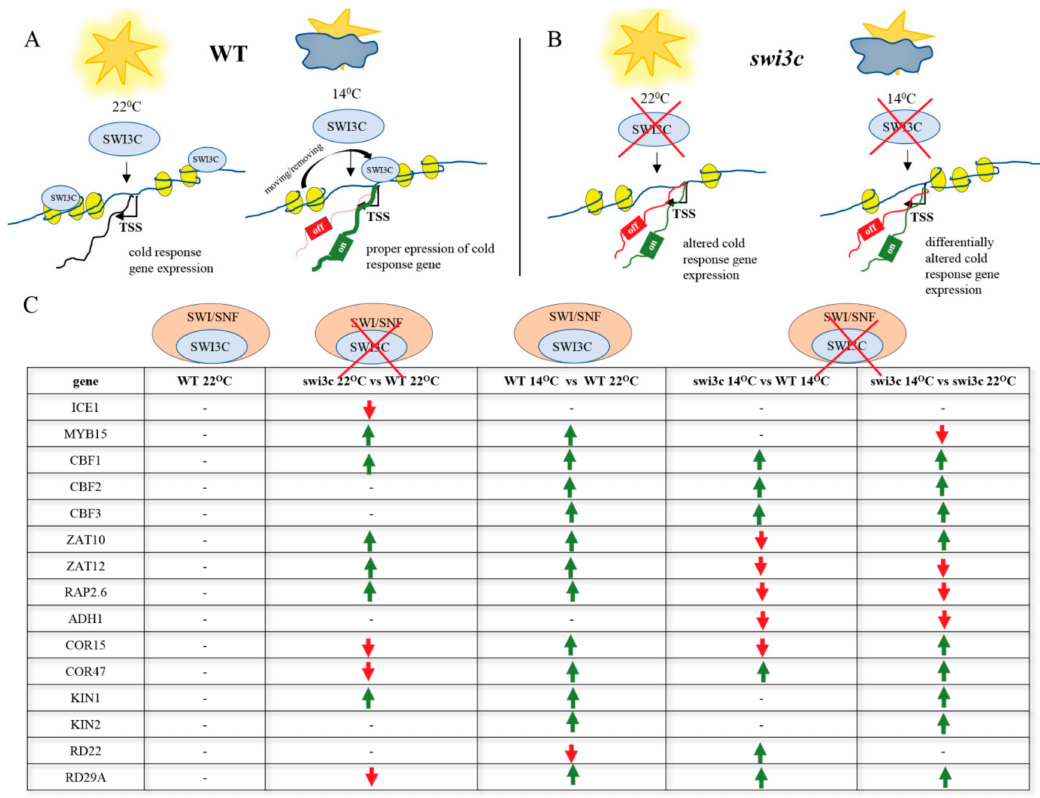
Figure 5. The Action of SWI3C-containing SWI / SNF CRCs in the Transcriptional Control of Genes in the Cold-Responsive Pathway Depends on the Growth Temperature. ( A ) Schematic model illustrating the role of intact SWI3C-containing SWI / SNF CRCs in the transcriptional control of ICE1 , CBF1 and MYB15 genes in WT plants. The SWI3C-containing SWI / SNF complex modulates the expression of cold-responsive genes in wild type plants at 22 ◦ C in di ff erent manner than during growth at 14 ◦ C. The position of SWI3C-SWI / SNF CRC localization di ff ers depending on the temperature. Blue circles indicate SWI3C protein and yellow ellipses represent nucleosomes. ( B ) Schematic model illustrating the impact of SWI3C inactivation on transcription of ICE1 , CBF1 and MYB15 genes in swi3c plants. Blue circles symbolize the SWI3C protein and yellow ellipses represent nucleosomes.( C ) The overview of transcriptional changes of cold-responsive genes in wild type and swi3c mutant plants. Green arrows mark elevated expression, red arrows indicate decreased